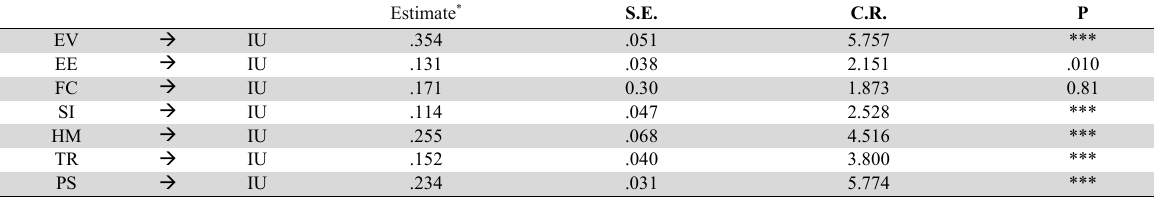
The regression coefficients of SEM